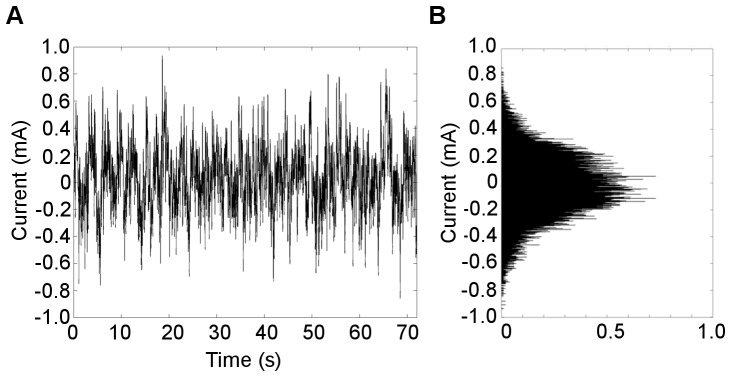
Characteristics of the stimulus.
A. Typical recording from a subject receiving a noisy stimulus applied for 72 s duration. The stimulus presented is at the highest current intensity (current level 6), which was set to 90% of the subject’s individual sensory threshold (RMS current value of 242 µA). B. Probability density function of the stimulus current follows a Gaussian distribution.